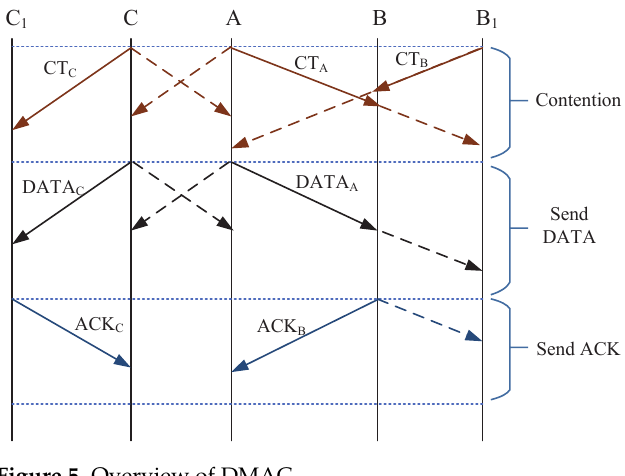
Figure 5. Overview of